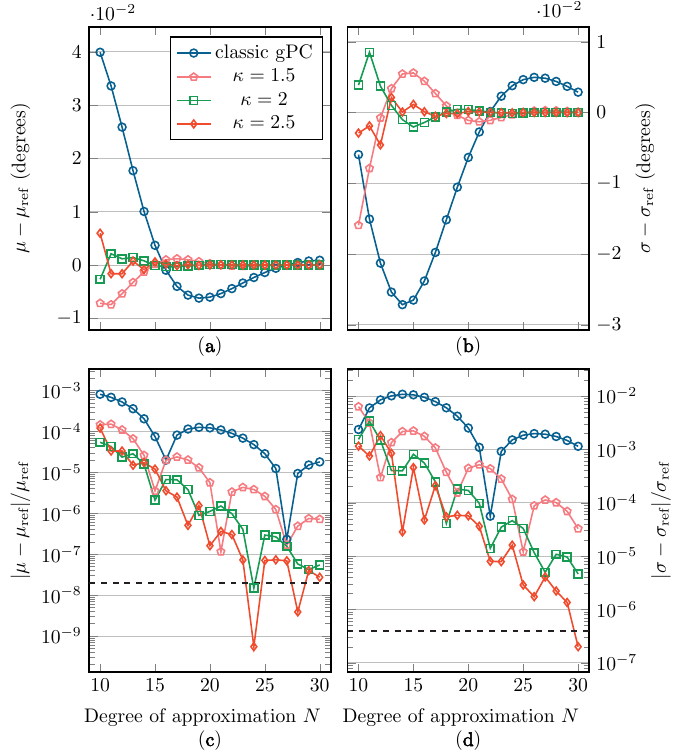
Figure 10. The absolute and relative errors on µ ( a , c ) and σ ( b , d ) with regard to their reference value when applying the Beta ( x ;1,1 ) distribution. The precision floor is shown by a dashed line.